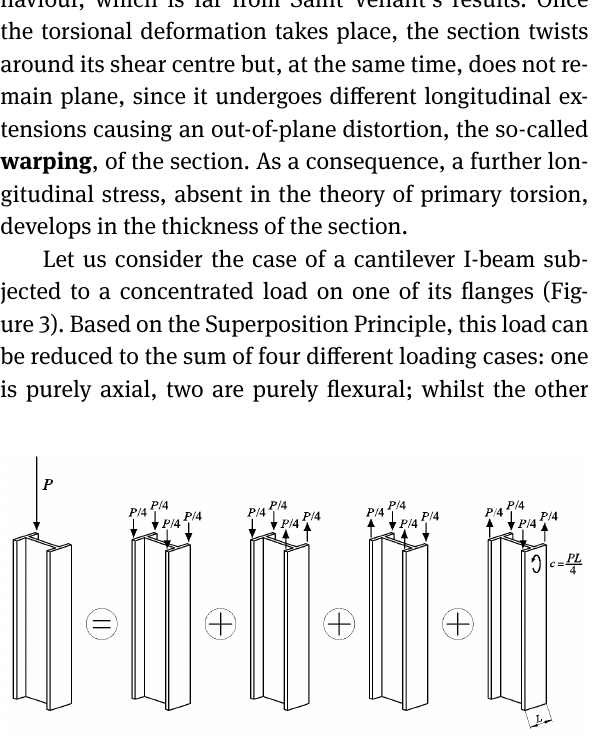
Figure 3: Cantilever I-beam subjected to a concentrated load on one of its